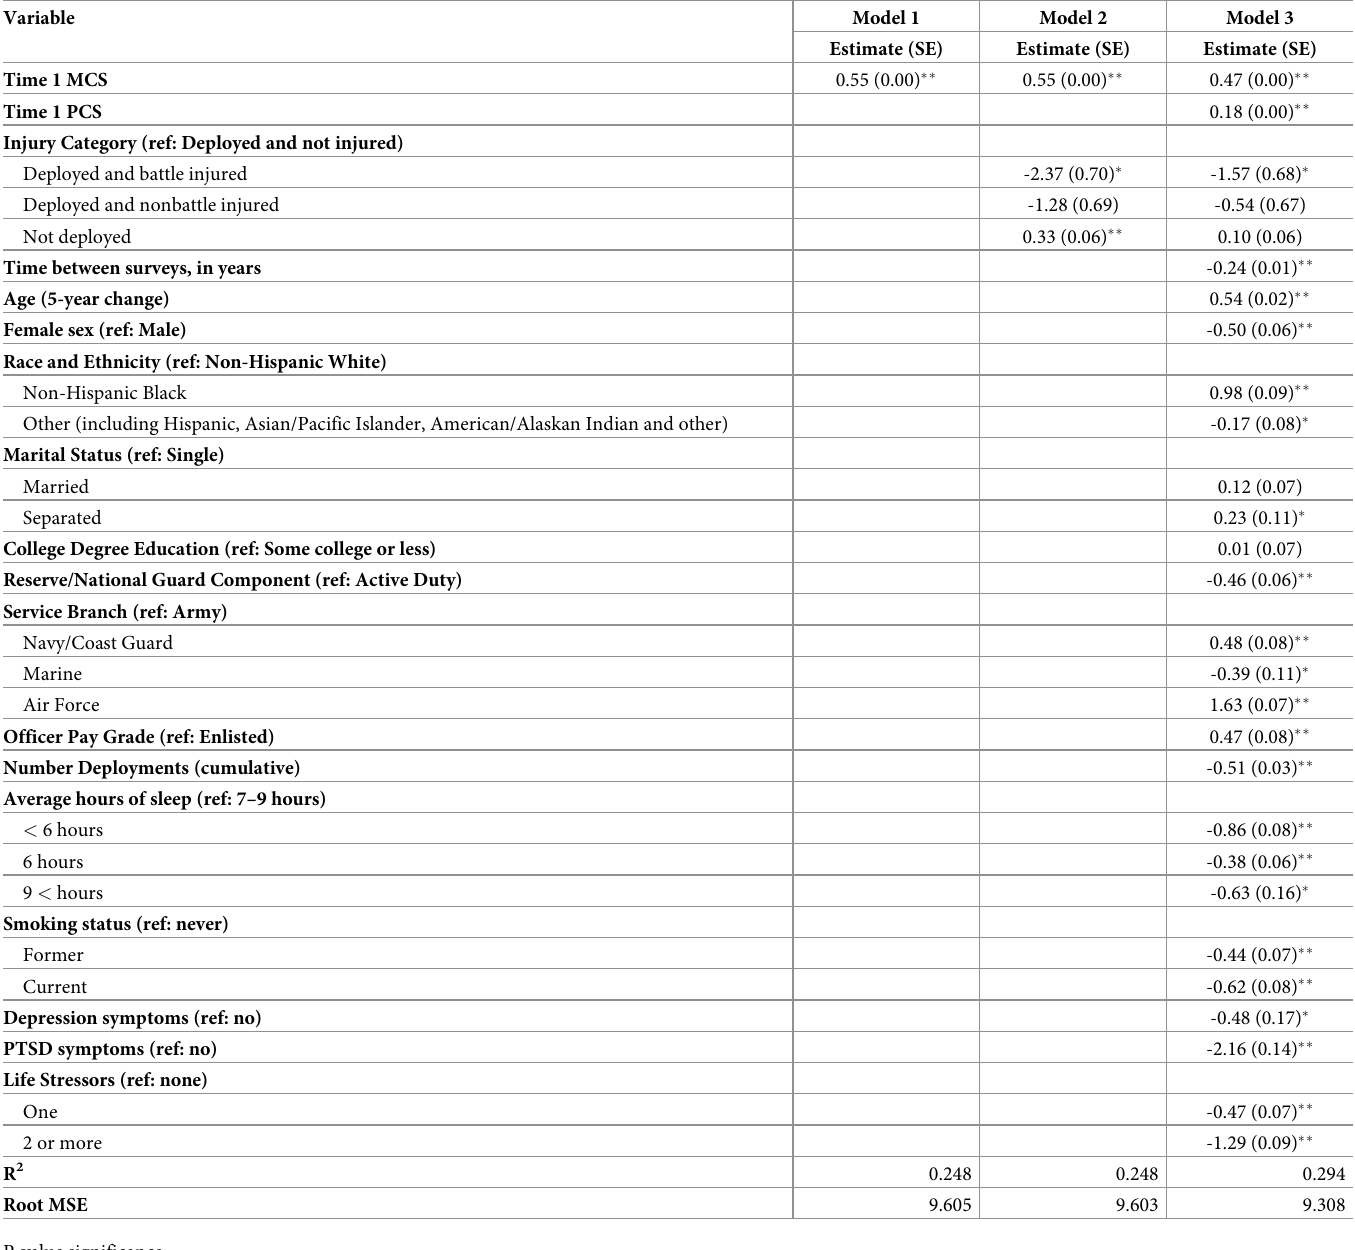
Table 2. Associations between main exposure and covariates with Mental Composite Scores (MCS) among Millennium Cohort participants, n =